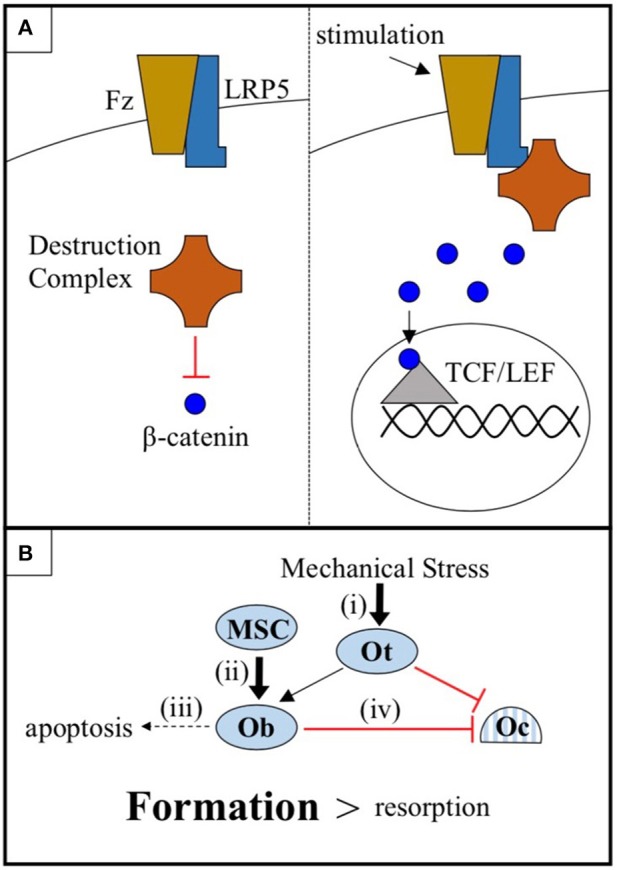
(A) The cytoplasmic destruction complex constitutively targets β-catenin for degradation. Mechanical or chemical stimulation of the Wnt-β-catenin pathway receptor pair LRP5-Frizzled (Fz), in cells of the osteoblast linage, causes LRP5 to sequester the destruction complex, allowing β-catenin to accumulate and translocate to the nucleus where it interacts with TCF/LEF family transcription factors and promotes osteogenic gene expression. (B) Osteocytes (Ot) sense mechanical stress and respond by increasing Wnt-β-catenin signaling and coordinating the anabolic activities of osteoblasts (Ob) and the catabolic activities of osteoclasts (Oc). Wnt-β-catenin signaling, in addition to (i) sensitizing osteocytes to mechanical stress, (ii) promotes the differentiation of mesenchymal stem cells (MSC) into osteoblasts, (iii) prevents osteoblast apoptosis, and (iv) increases osteoprotegerin expression by osteoblasts, thus inhibiting osteoclast-mediated bone resorption. The net effect is a shift in favor of bone formation over bone resorption.